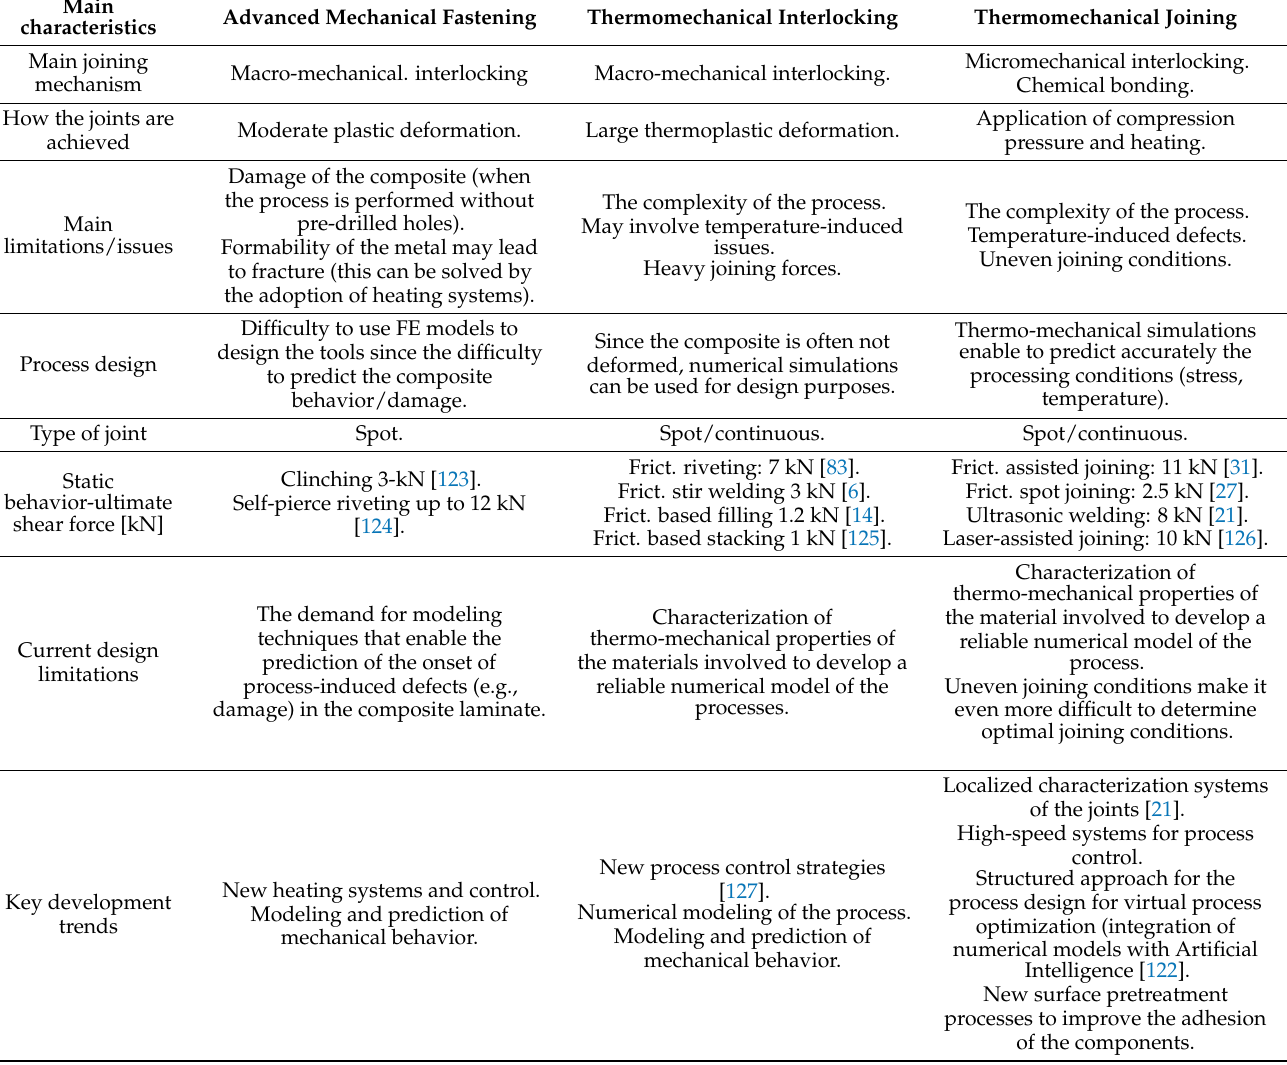
Table 3. Main characteristics of advanced joining